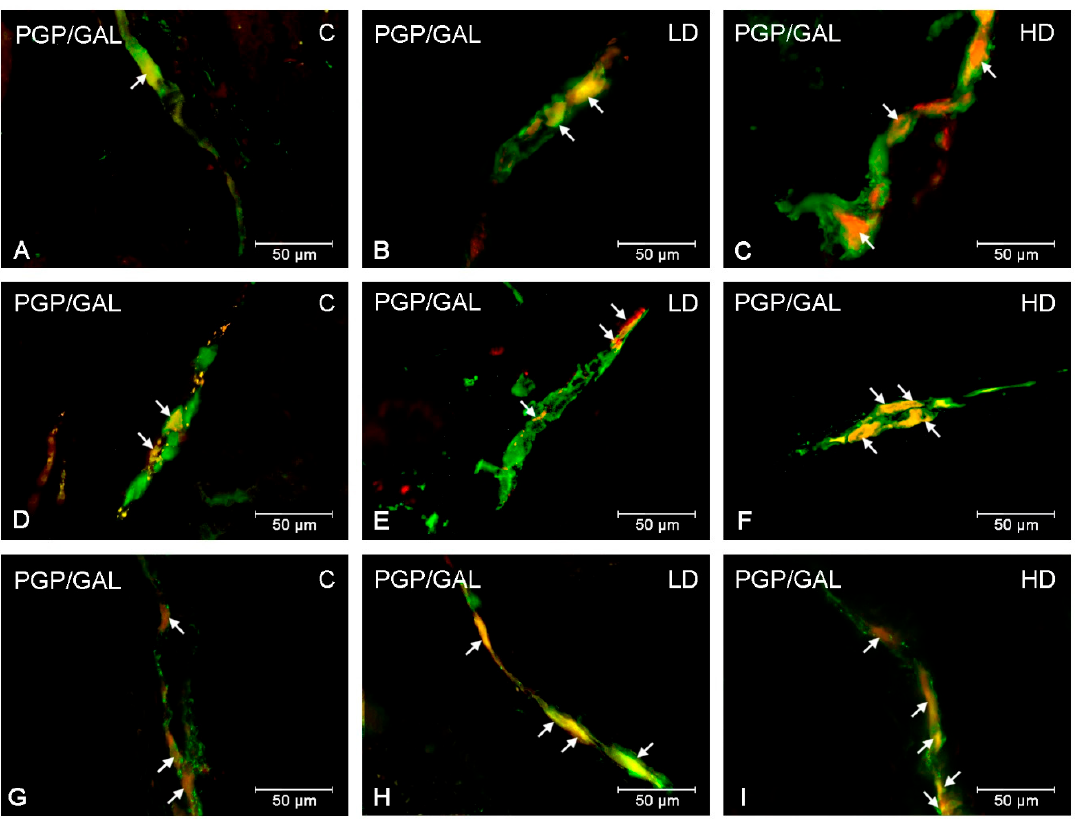
Figure 1. GAL-LI neurons in myenteric plexuses in the porcine stomach. The ENS neurons immunoreactive to protein gene-product 9.5 (PGP9.5)—used as a pan-neuronal marker and galanin (GAL) in myenteric plexuses in the porcine stomach under physiological condition ( A , D , G ), after low ( B , E , H ) and high doses ( C , F , I ) of acrylamide supplementation. Photographs A–C showing myenteric plexuses in the cardia, D–F—myenteric plexuses in the corpus and G–I—myenteric plexuses in the pylorus. All photographs have been created by digital superimposition of two colour channels (green for PGP 9.5 and red for GAL). Neurons immunoreactive to GAL are indicated with arrows.